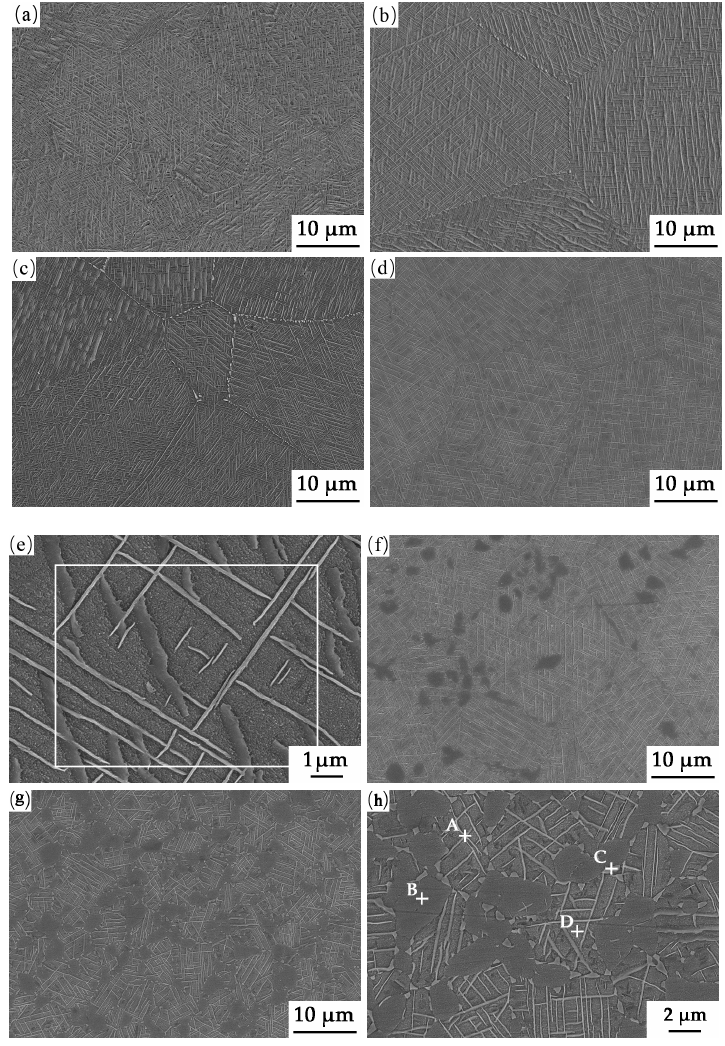
Figure 7. SEM images of microstructures of 12AgCuZnSn-2In-0.15Pr- x Ga filler metals (“ x ”: the mass fraction of Ga): ( a ) x = 0, ( b ) x = 0.5, ( c ) x = 1, ( d ) x = 2, ( e ) x = 2 (high magnification), ( f ) x = 3, ( g ) x = 5, and ( h ) x = 5 (high magnification). Table 2. EDS analysis of the points indicated in Figure 7 (at.%).